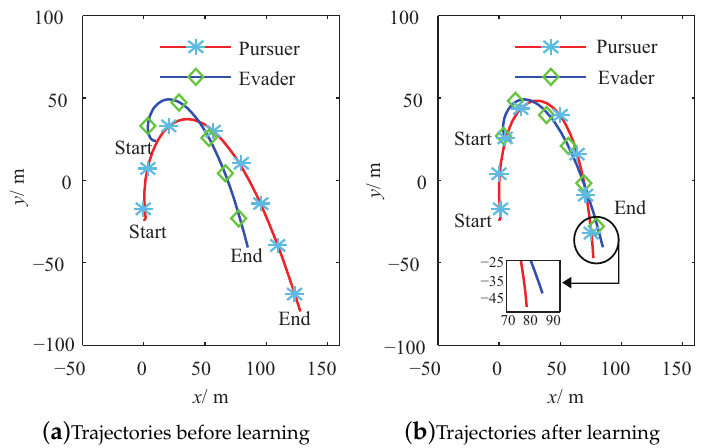
Figure 5. Trajectories of the pursuer and the evader in the X – Y plane.